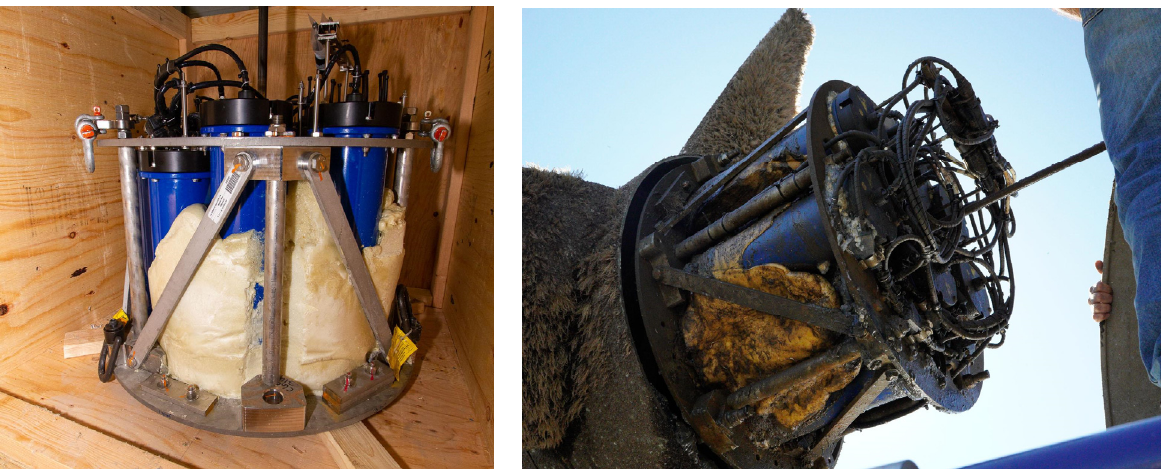
Figure 9. NDAQ with foam fill ( left ) before deployment and ( right ) after deployment.